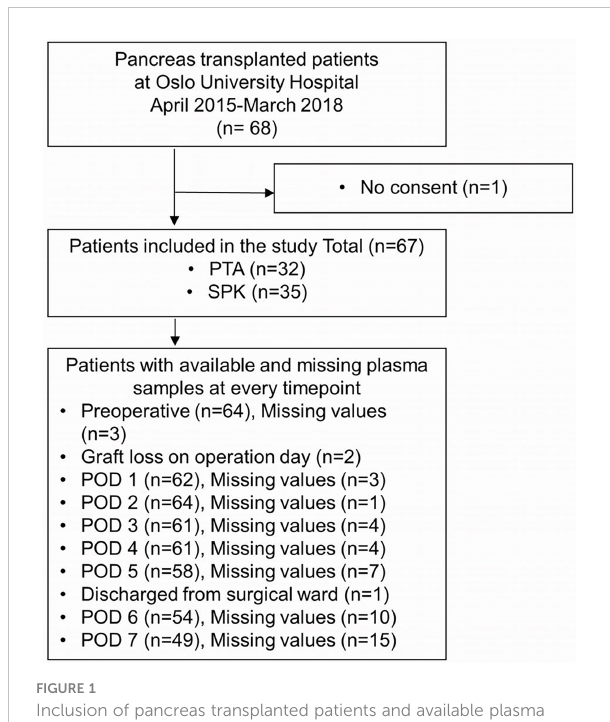
FIGURE 1 Inclusion of pancreas transplanted patients and available plasma samples throughout the study. PTA, pancreas transplant alone; SPK, simultaneous pancreas-kidney transplantation; POD, postoperative day.